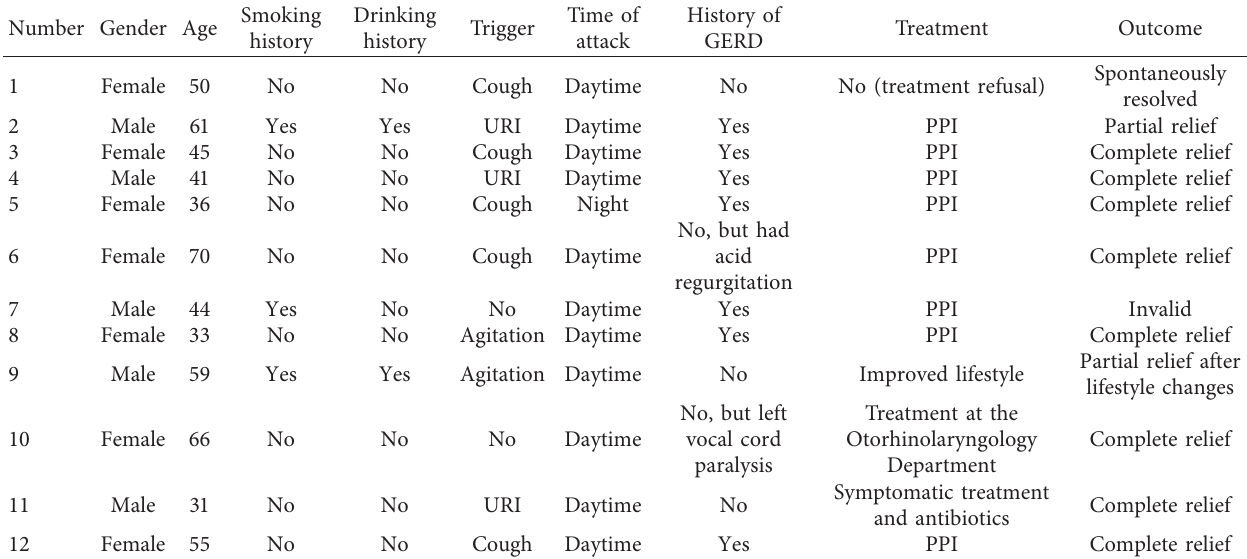
Table 1: Patient-related